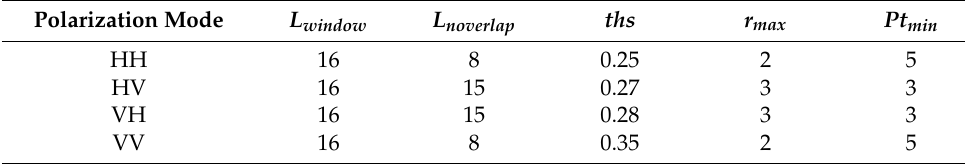
Table 3. Setting values of various parameters at different polarizations.